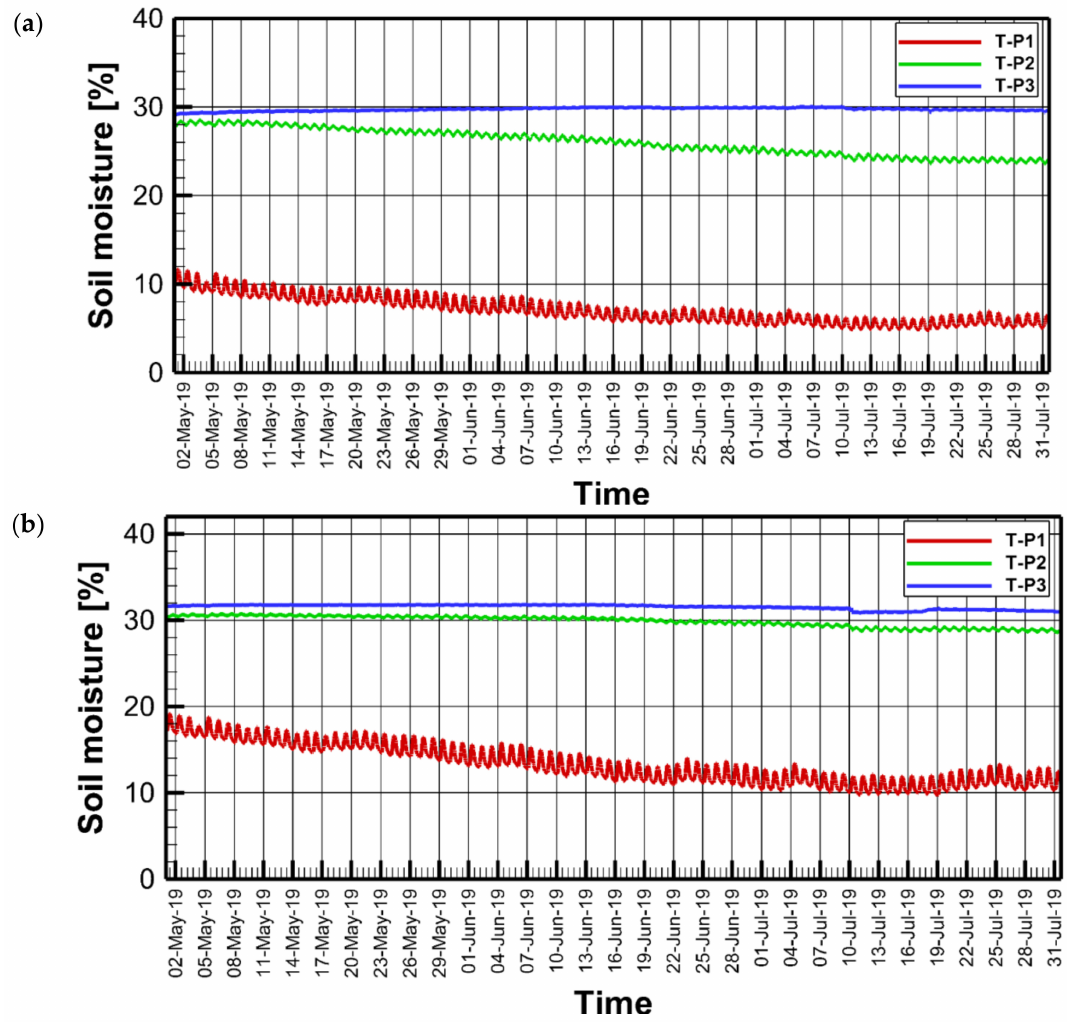
Figure 10. Soil moisture during May–July 2019 for lysimeter 1 ( a ) and lysimeter 2 ( b ). Table 4 summarizes the results of this study for the hydrological year 2018/2019. The table shows the monthly and the annual water